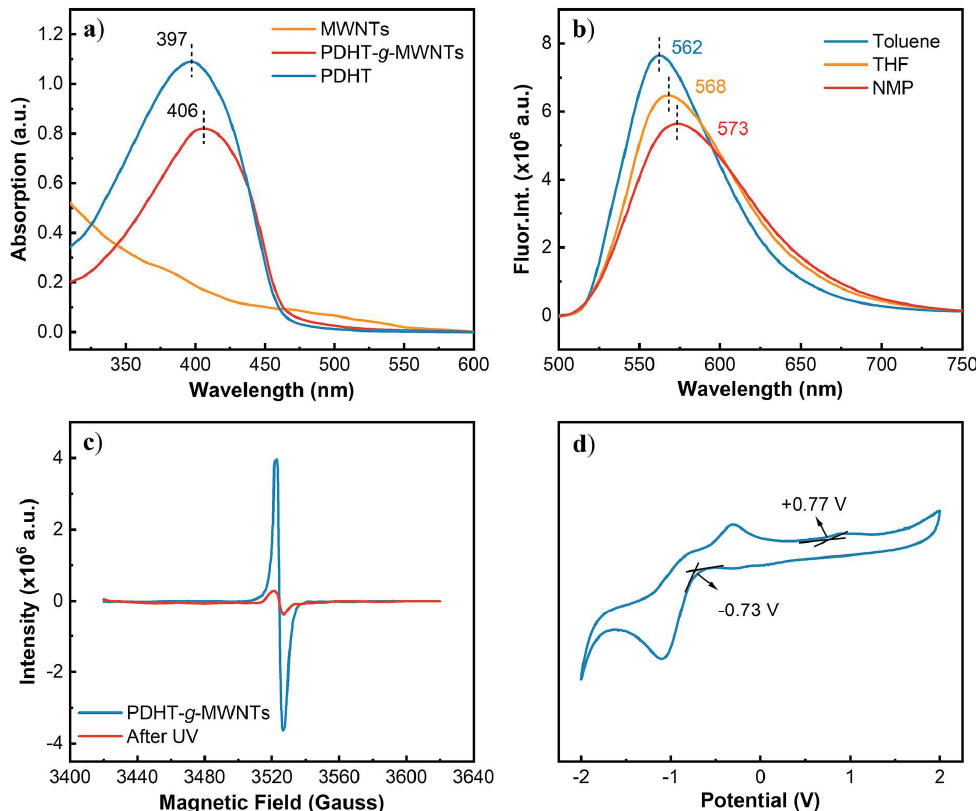
Figure 2. ( a ) UV-vis spectra of MWNTs, PDHT, and PDHT- g -MWNTs. ( b ) Photoluminescence spectra of PDHT- g -MWNTs in different solvents ( λ ex = 400 nm). ( c ) EPR spectra of PDHT- g -MWNTs before and after 450 nm laser illumination. ( d ) The cyclic voltammetry curve of the PDHT- g -MWNTs film.